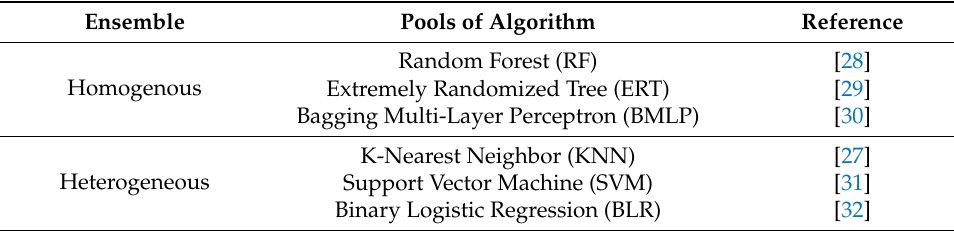
Table 2. Pools of various classification algorithms for the study. Ensemble Pools of